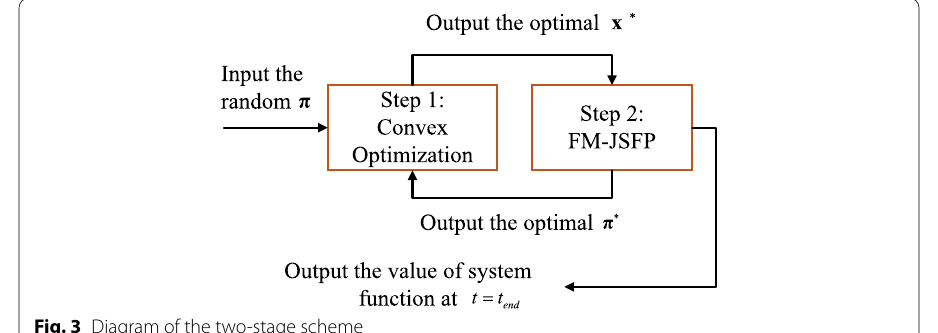
Fig. 3 Diagram of the two-stage